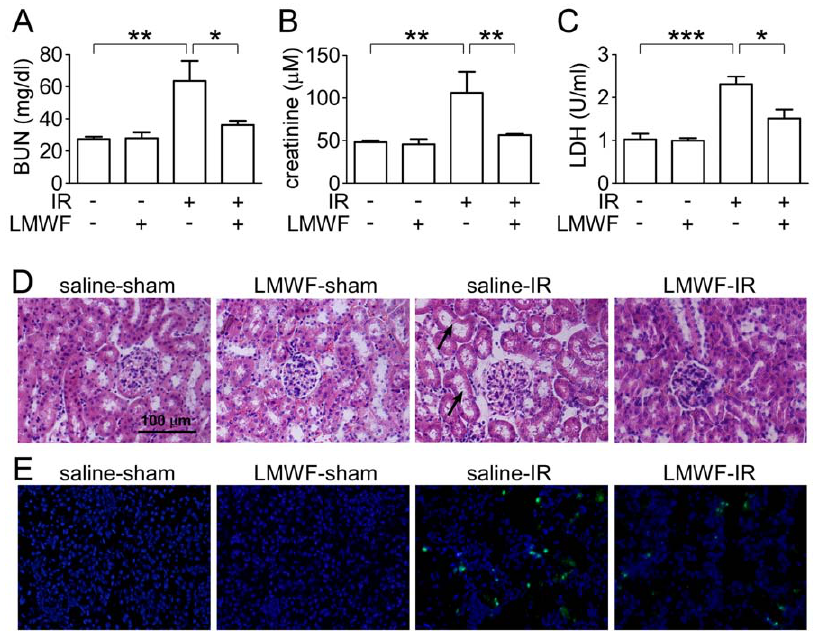
Figure 1. LMWF reduced renal functional defect and tissue damage caused by IR. C57BL/6J mice were administered with vehicle or LMWF daily for 7 days before surgery. Serum and kidneys were collected for renal function test and histological examination after reperfusion for 24 h. (A) Serum BUN. (B) Serum creatinine concentration. (C) Serum LDH activity. (D) Representative images of H&E staining of kidney (original magnification 6 400). Arrow: lysed tubules. (E) Representative images of TUNEL (green fluorescence) and Hochoest (Nuclei) staining of kidney (original magnification 6 400). Data are presented as mean 6 SEM. n=5–8 for each group. * P , 0.05; ** P , 0.01; *** P , 0.001.